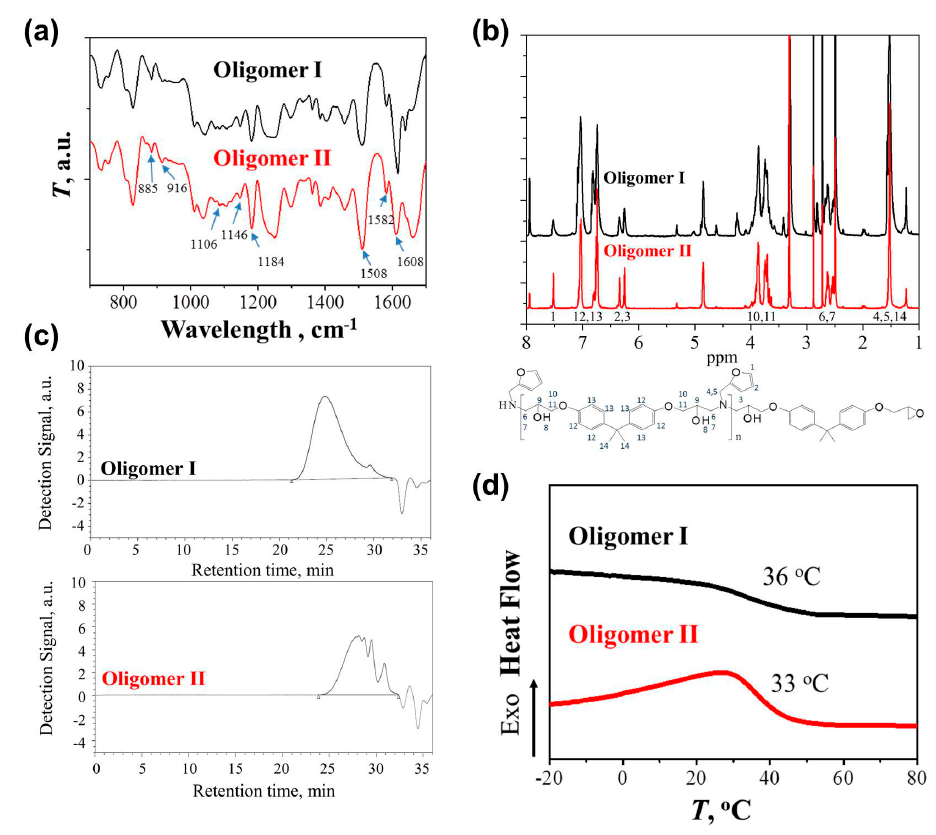
Figure 1. ( a ) Fourier transform infrared spectroscopy (FTIR) spectra; ( b ) 1 H-NMR spectra; ( c ) Gel permeation chromatography (GPC) plots; and ( d ) Differential scanning calorimetry (DSC) curves of Oligomers I and II.